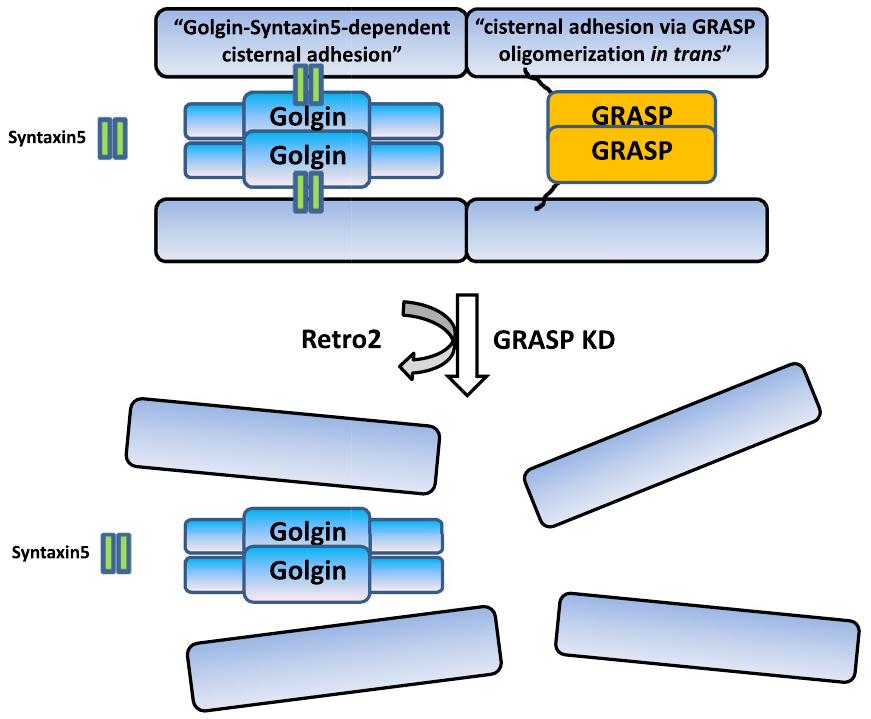
Figure 6. A model depicting how Golgin-Syntaxin5 interaction may assist or support cisternal adhesion during interphase. We suggest that GRASP-dependent cisternal adhesion and direct interaction between Syntaxin5 and Syntaxin5-binding Golgin tethers likely support cisternal adhesion in incremental or additive manner. In GRASP-depleted cells, Retro-2 treatment leads to complete disassembly of the Golgi within a few hours, because of rapid displacement of Syntaxin5 from the Golgi. It is noteworthy that this unique Golgin-tSNARE interaction may not only assist cisternal adhesion during interphase, but also influence the frequency of inter-cisternal fusion among closely apposed Golgi cisterna or lateral linking of stacks for Golgi ribbon